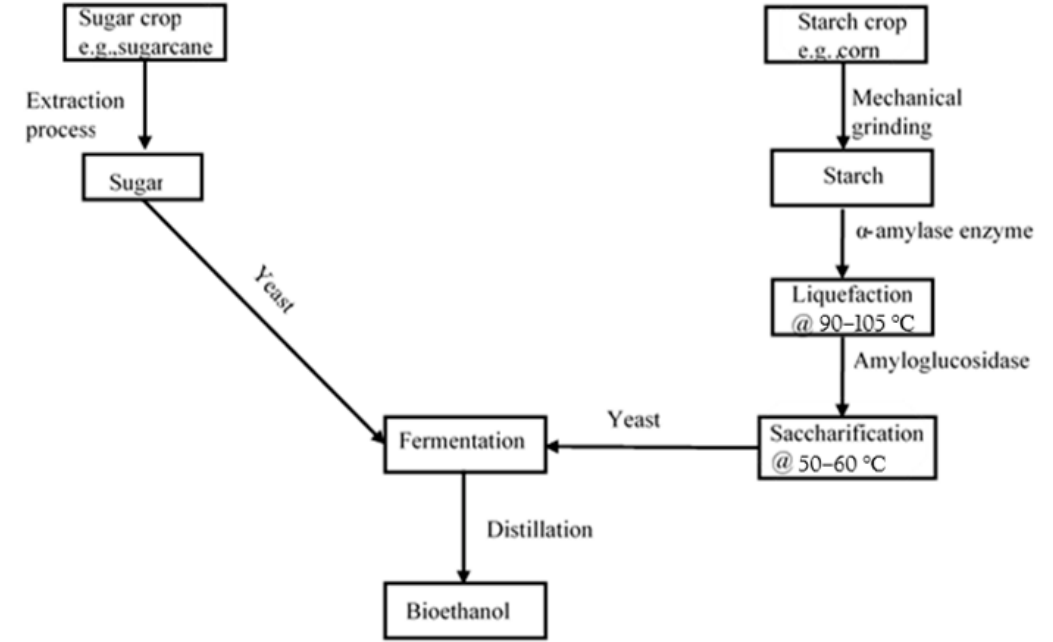
Figure 1. General schematic diagram of bioethanol production from first-generation